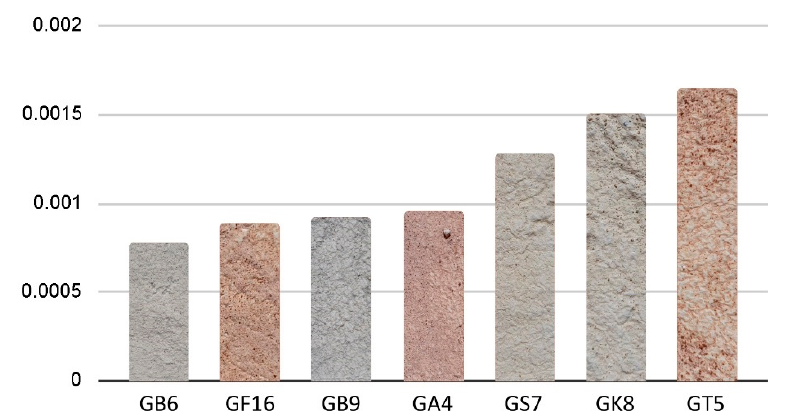
Figure 20. Summary of results for abrasion test based on the clay soil (granulometry < 2 mm).